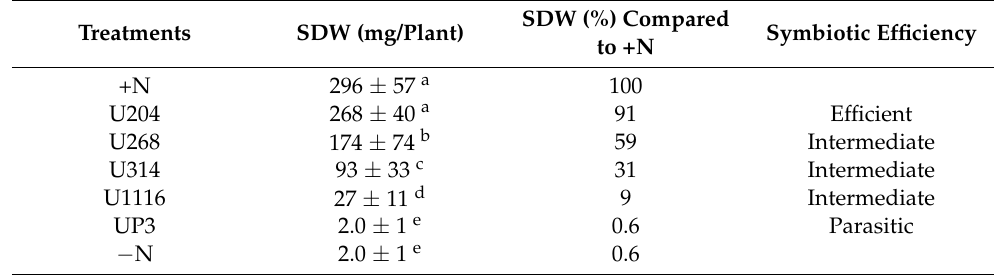
Table 3. Symbiotic efficiency of rhizobia strains on T. repens in controlled conditions. Non-inoculated plants fertilized with nitrogen (+N) or non-fertilized ( − N) were the controls. SDW (shoot dry weight) aerial biomass accumulated after two harvests or cuts, at 35 and 60 dpi. Means of SDW ± standard error are shown. Different letters indicate statistical differences ( p < 0.05).